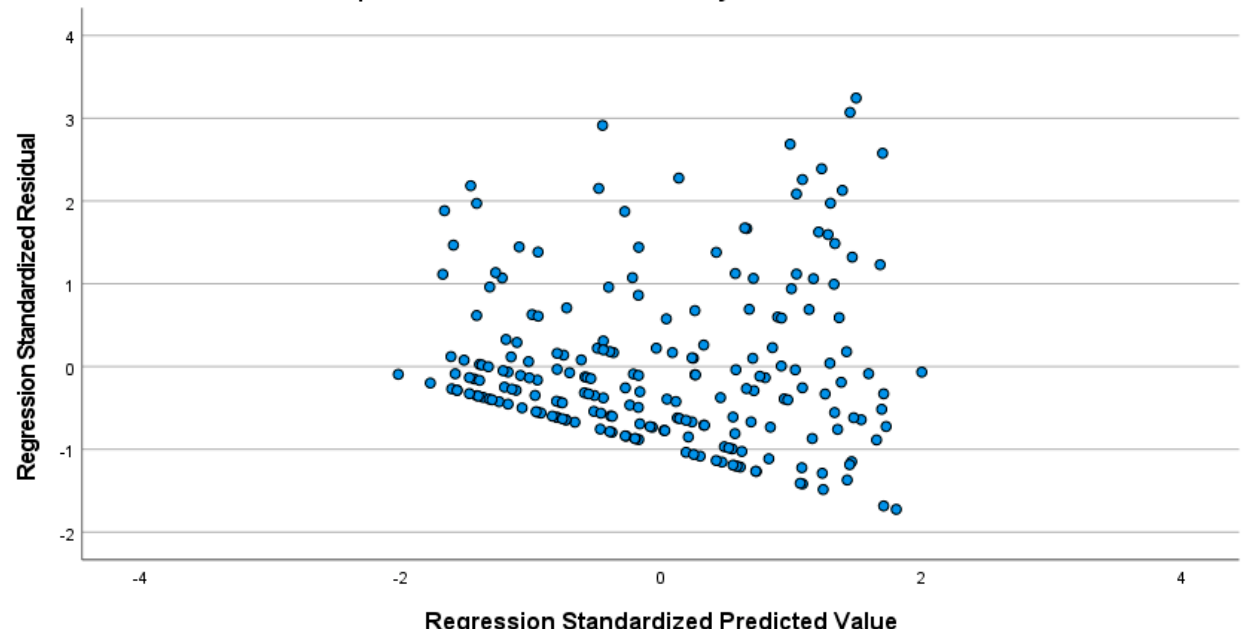
Figure A2. Scatterplot showing standardized residuals for SCL-90 Anxiety scale.